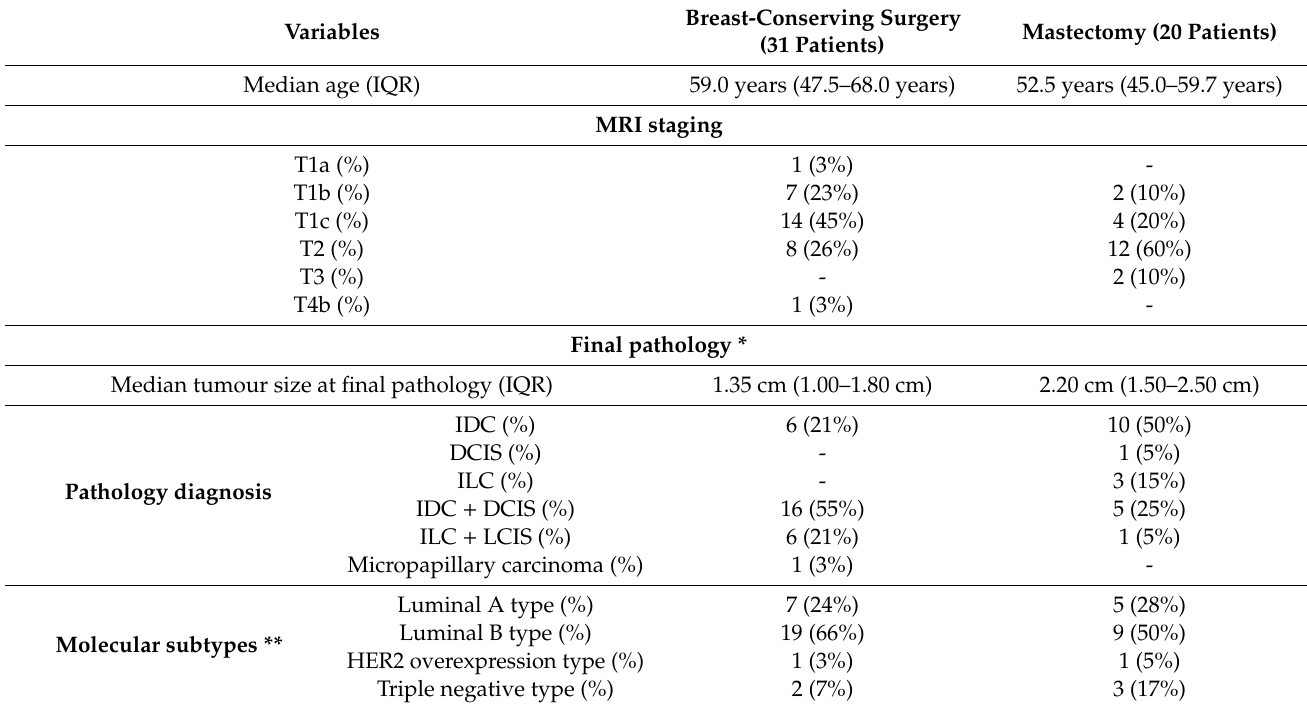
Table 2. Demographics, staging, and pathology findings.